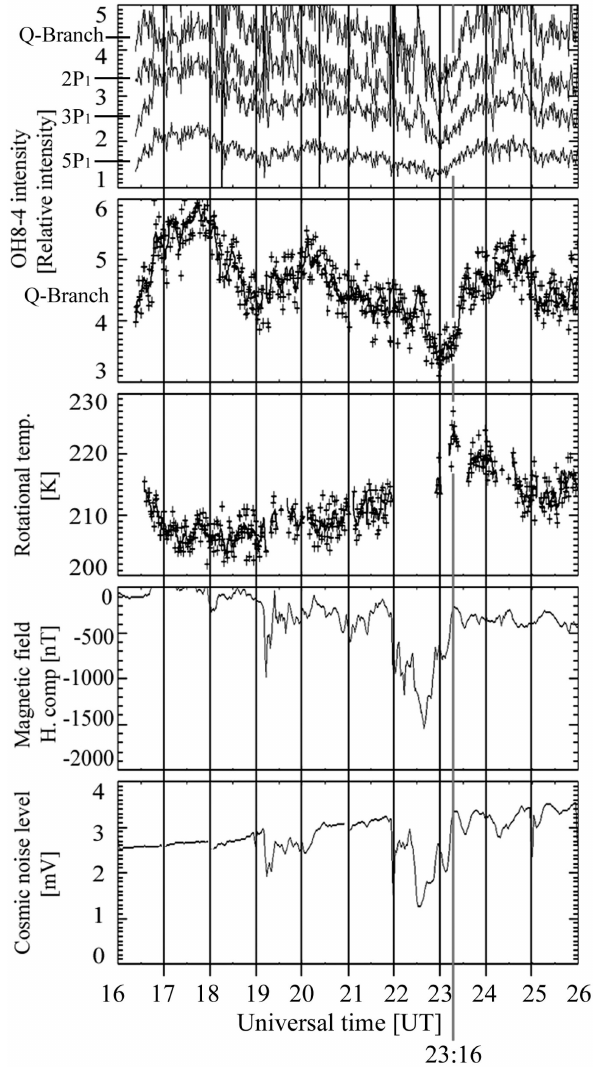
Fig. 2. Variations in the OH rotational temperature and intensity Figure 2. Variations in the OH rotational temperature and intensity (upper two panels) 2 (upper two panels) observed on 27/28 March 2008. The intensity of the Q-branch, P 1 (2), P 1 (3), and P 1 (5) are also plotted in the upper observed on 27/28, March, 2008. The intensity of the Q-branch, P panel. The second panel is the intensity of the Q-branch, which is are also plotted in the upper panel. The second panel is the intensity of the Q-branch, 4 the same as in the upper panel, but at a different scale. The hori- zontal component of the magnetic field and cosmic radio noise ab- which is the same as in the upper panel, but at a different scale. The horizontal 5 sorption (CNA) observed at the Syowa Station are displayed in the bottom two component of the magnetic field and cosmic radio noise absorption (CNA) observed at 6 the Syowa Station are displayed in the bottom two panels. 7